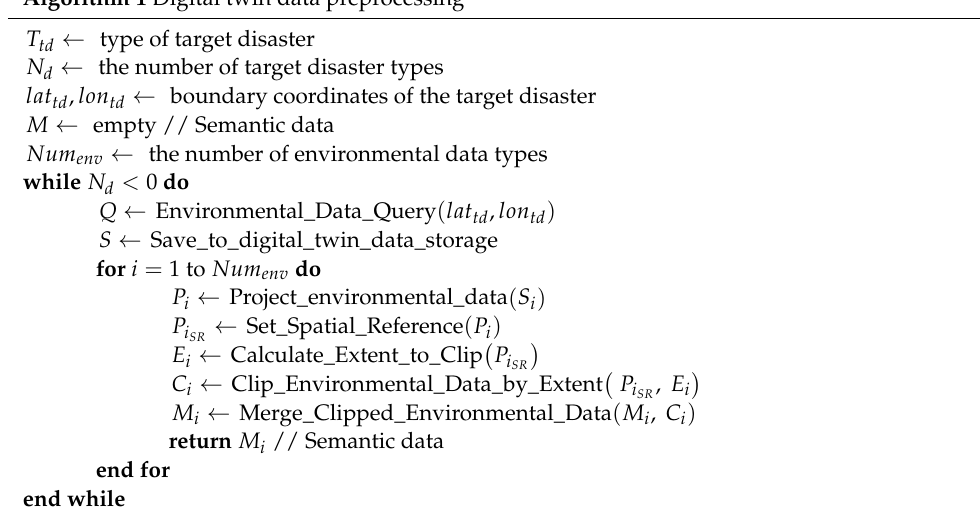
Algorithm 1 Digital twin data